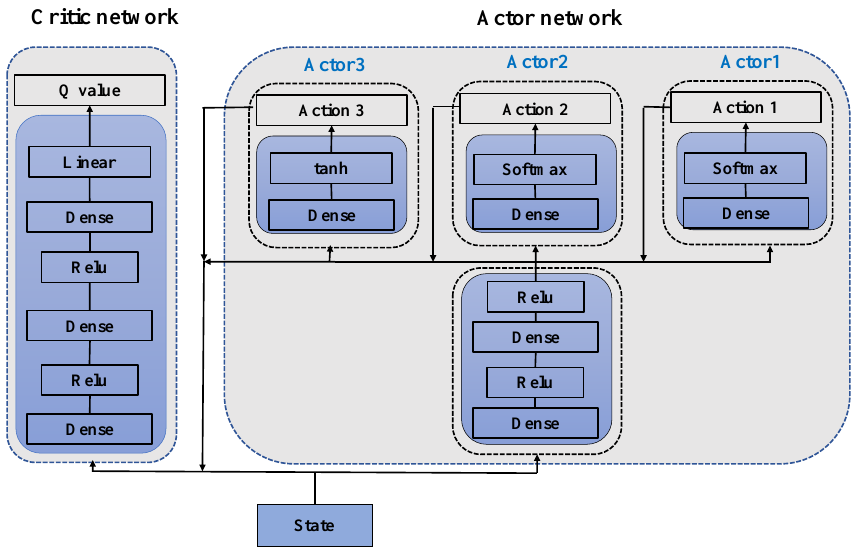
Figure 3. The Actor-Critic